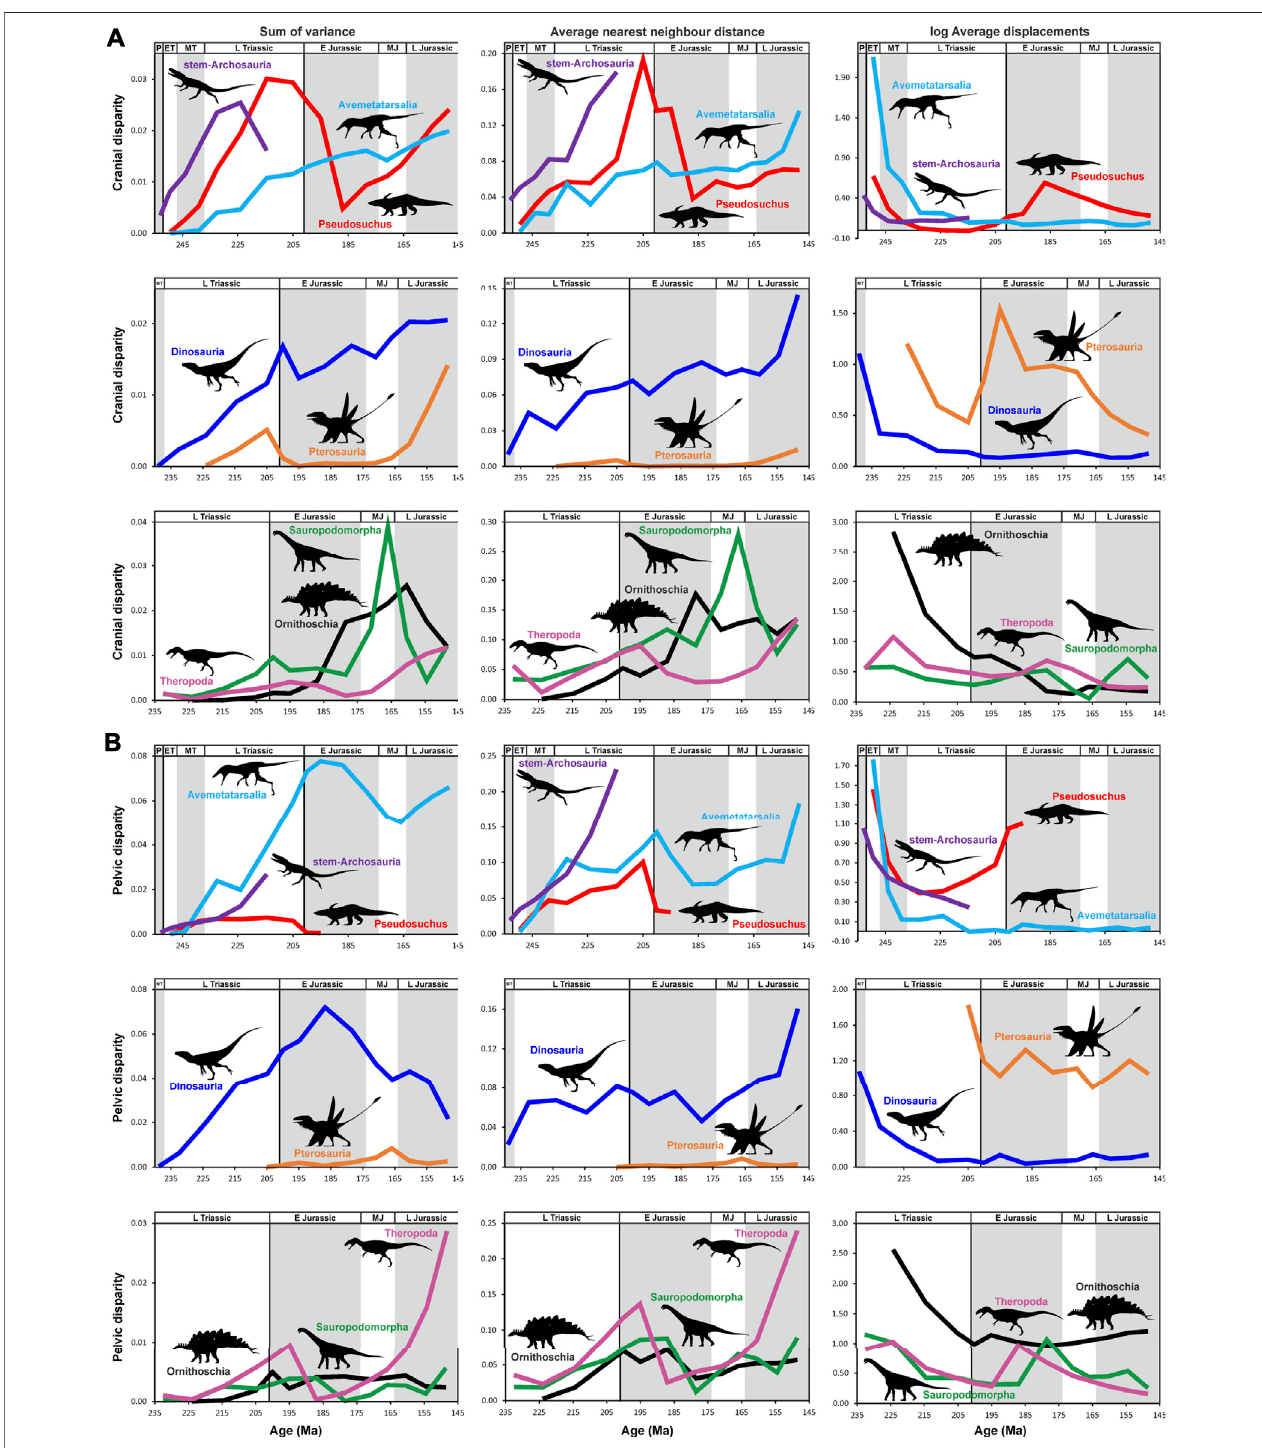
FIGURE9| Comparisonofmediancraniumandpelvisdisparitycapturedby2DgeometricmorphometricsfromthelatePermiantoLateJurassicbetweendifferent archosauromorph groups, as measured from phylogenetically interpolated values ( “ gradualistic ” model), with disparity quanti fi ed as the sum of variances, average nearest neighbor distance and average displacements (log-transformed) based on shape variables of the principal component analysis. (A) Cranial disparity of stem- archosaurs (dark purple line), pseudosuchians (red line), avemetatarsalians (cyan line), dinosaurs (blue line), pterosaurs (orange line), ornithischians (black line), theropods (magenta line) and sauropodomorphs (green line). (B) Pelvic disparity of stem-archosaurs (dark purple line), pseudosuchians (red line), avemetatarsalians (cyan line), dinosaurs (blue line), pterosaurs (orange line), ornithischians (black line), theropods (magenta line) and sauropodomorphs (green line). All silhouettes taken from (www.phylopic.org). Abbreviations: P, Permian; ET, Early Triassic; MT Middle Triassic L Triassic, Late Triassic; E Jurassic, Early Jurassic; MJ, Middle Jurassic; L Jurassic, Late Jurassic ( Supplementary Material S1-Tables S4 – S6 ).